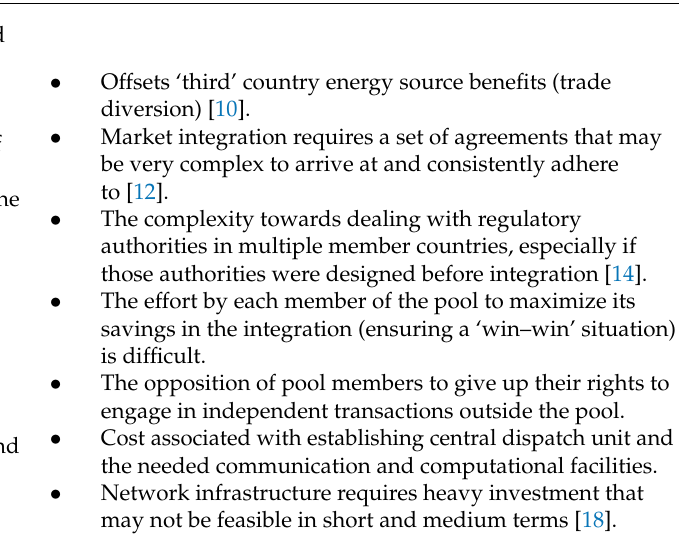
Table 1. A summary of costs and benefits of integrating energy markets [10–18]. Benefits